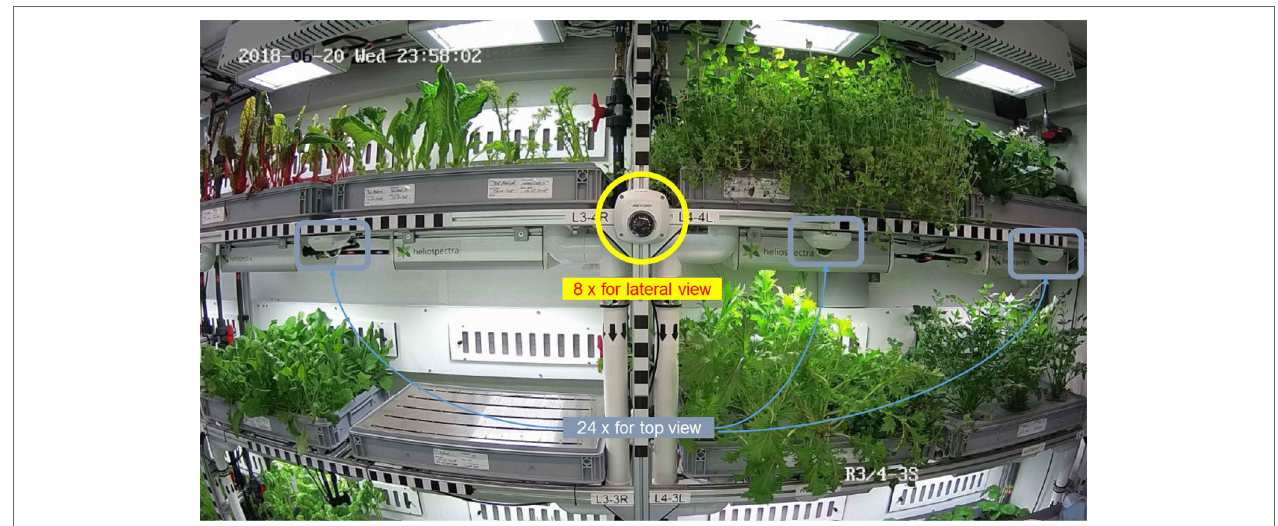
FIGUrE 5 | HD Color Imaging System configuration shown in a lateral view